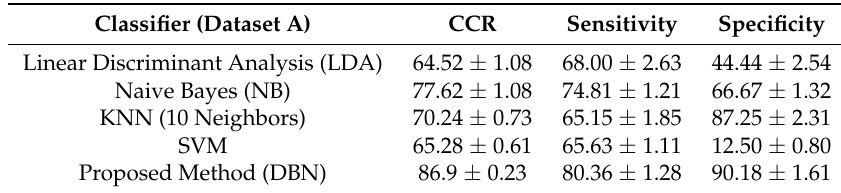
Table 7. Average value of correct classification rate, sensitivity and specificity ± standard deviation for Dataset A.